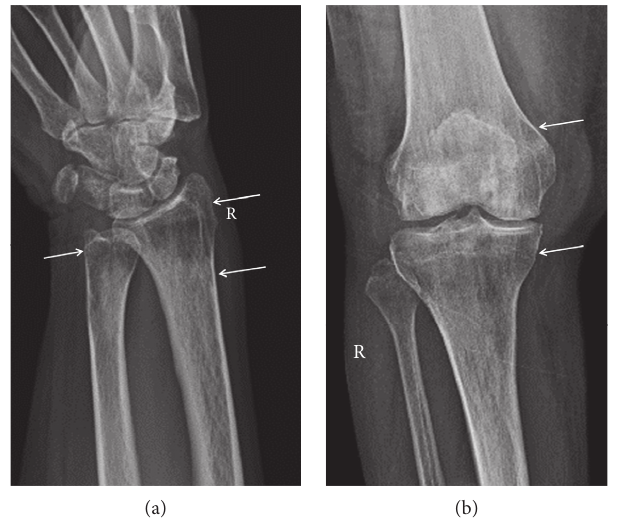
Figure 4: Osteoporosis. Demineralization with predominance of the distal radius and ulna and around the knee, with cortical thinning due to subperiosteal resorption (arrows).